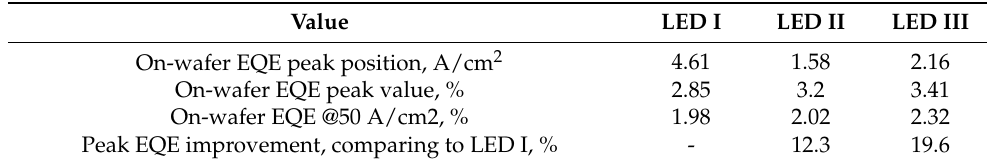
Figure 5. On-wafer EQEs of experimental LEDs with current plotted in ( a ) linear scale and ( b ) log- arithmic scale. Table 1. Characterization of on-wafer EQE behavior.